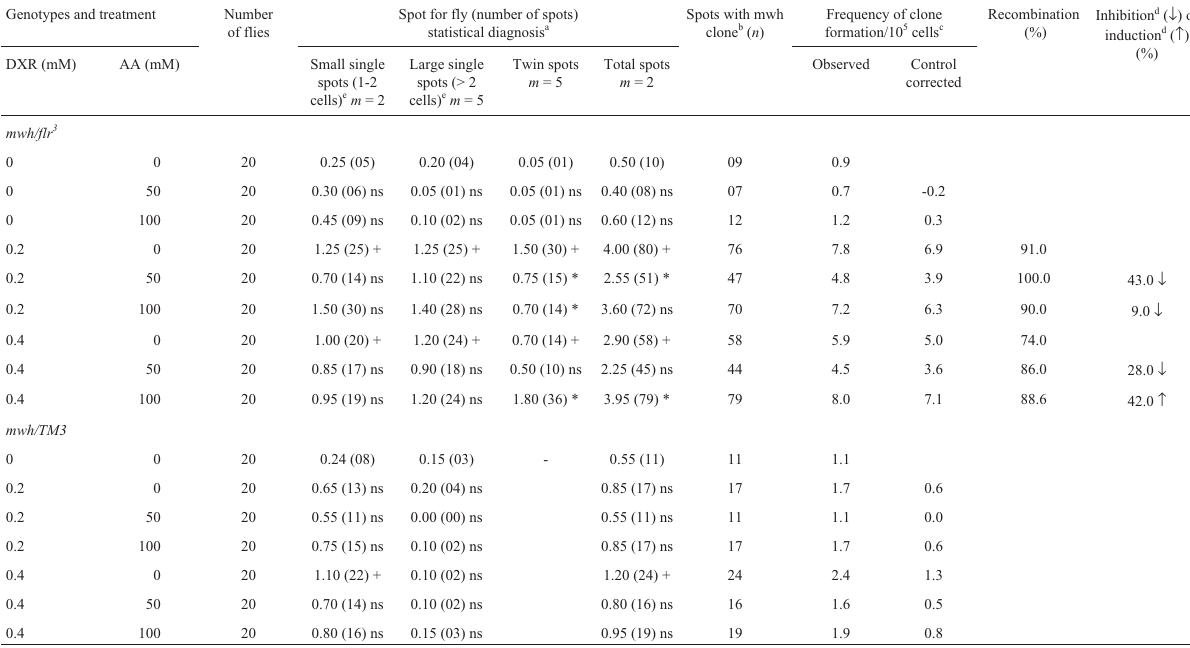
Table 1 - Summary of results obtained with the Drosophila somatic mutation and recombination test (SMART) in the marker-heterozygous (MH) and balancer-heterozygous (BH) progeny of the standard (ST) cross after chronic treatment of larvae with ascorbic acid (AA) and doxorubicin (DXR). Genotypesandtreatment Number Spotforfly(numberof spots) offlies statisticaldiagnosis